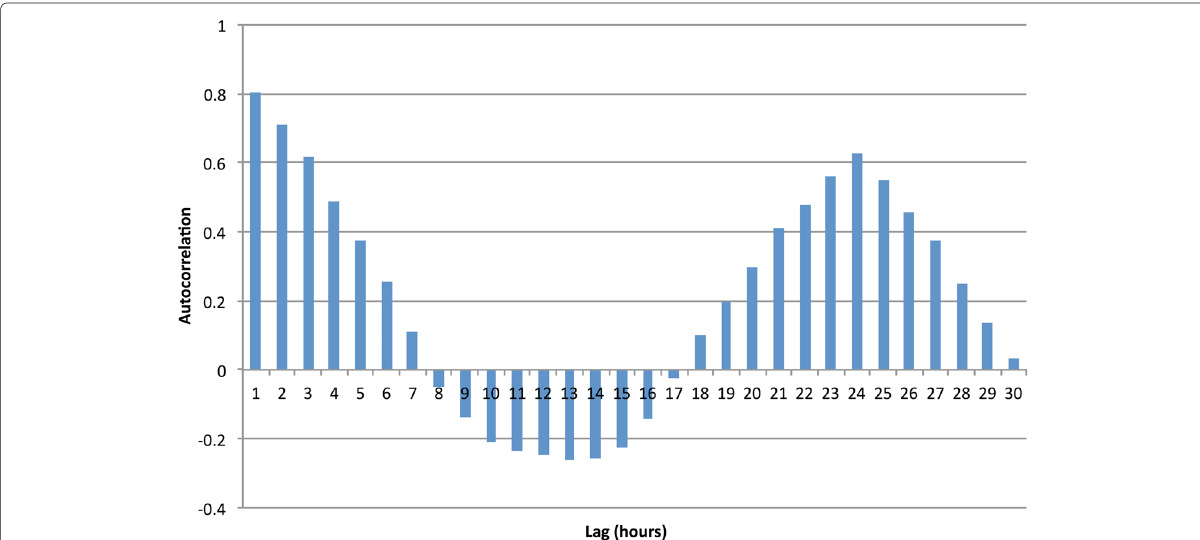
Fig. 4 Autocorrelation analysis of input training data. To choose an appropriate lag period, we analyzed the seasonal patterns of the time series, by measuring the autocorrelation of the input training data for different lag values, as shown in this figure. This was achieved using the Excel autocorrelaction function ( r k , where k is the lag interval), which is computed, as r k = s k / s 0 , where s k is the autocovariance function at lag k , and s 0 is the variance of the time series. As we can see in this figure, the input data exhibit a clear autocorrelation for a lag interval of 24 h. For this reason, the chosen lag period was T = 24